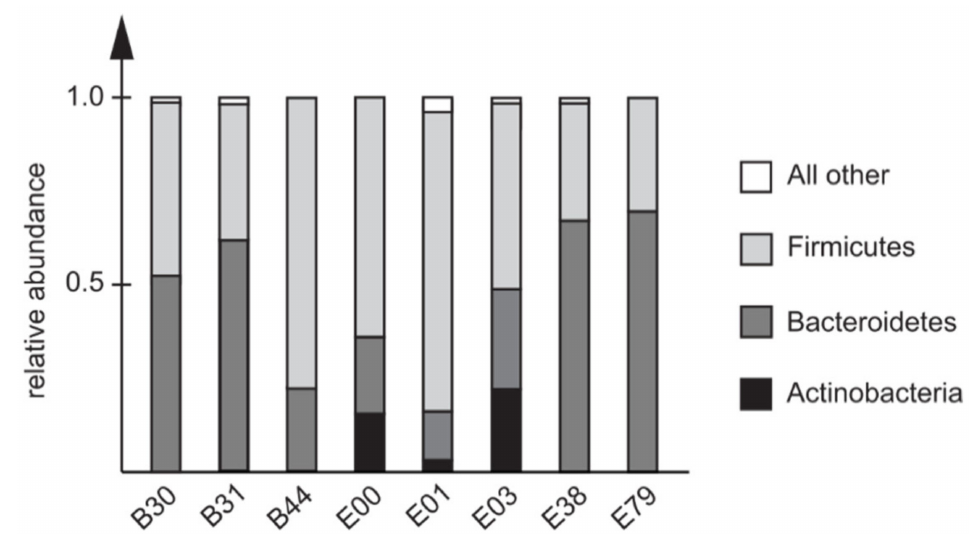
Figure 3. Composition of fecal microbiota prior to travel in individuals later infected with C. jejuni ST353CC isolates. The relative abundance of detectable phyla is shown for each individual. Three individuals (B30, B31, and B44) included meat in their diet whereas the rest of the subjects adhered to a non-meat